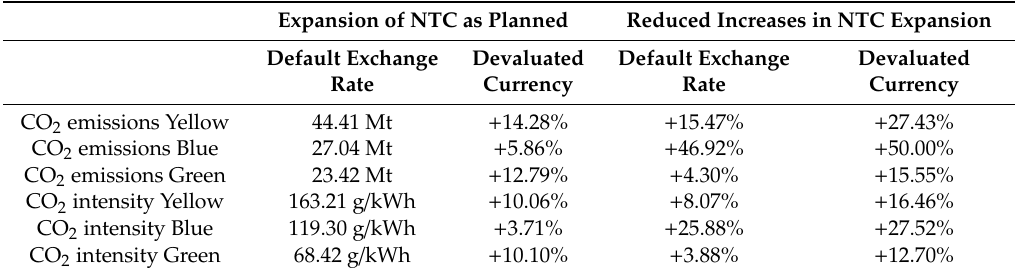
Table 4. Sensitivity of CO 2 emissions with regard to reduced net transfer capacity (NTC) expansion and depreciation of the Pound. Source: Own calculation.